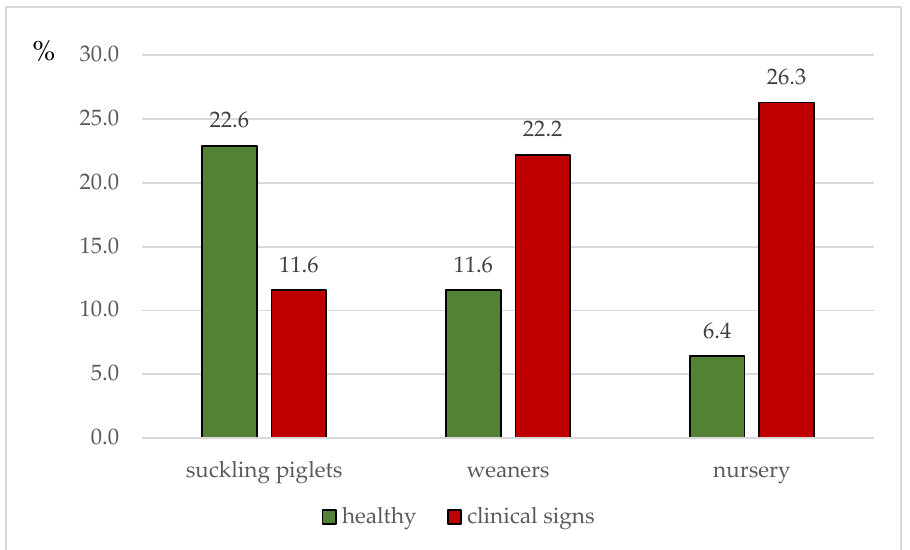
Figure 2. The percentage of piglets with and without clinical signs indicative of swine influenza (including, dyspnea, coughing, sneezing, nasal discharge, anorexia, and/or lethargy) among suckling piglets, weaners, and nursery pigs in relation to all samples ( n = 750).